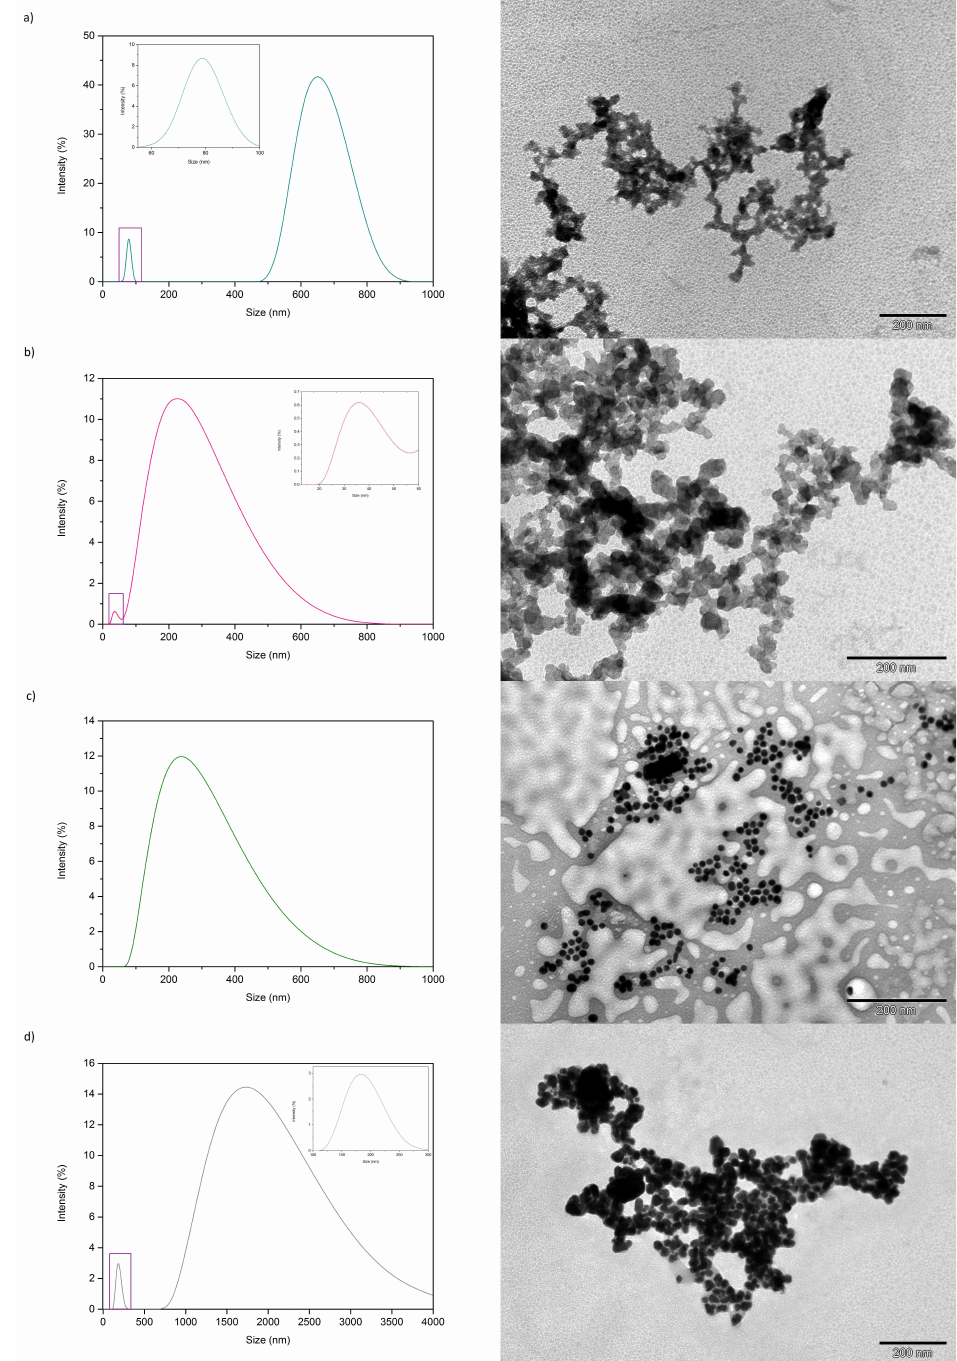
Figure 7. Synthesis of nanoparticles with eucalyptus extract and Cu(NO 3 ) 2 · 3H 2 O, Fe(NO 3 ) 3 · 9H 2 O, Ni(NO 3 ) 2 · 6H 2 O, and AgNO 3 0.1 M at 25 ◦ C: TEM images and DLS diagram. ( a ) Copper NPs; ( b ) iron NPs, ( c ) nickel NPs, and ( d ) silver